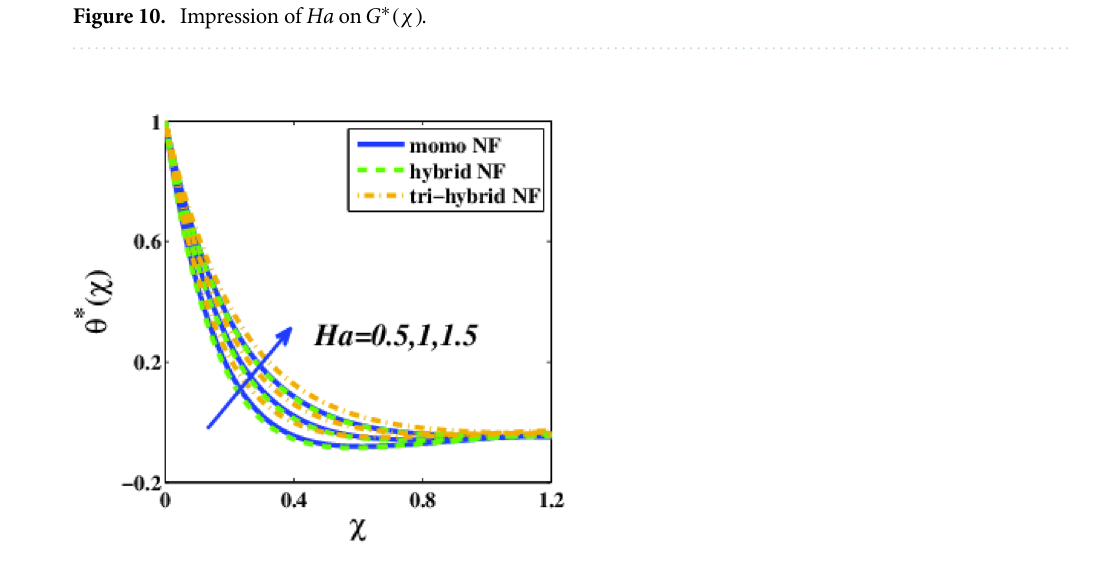
Figure 11. Effect of Ha on θ ∗ (χ)